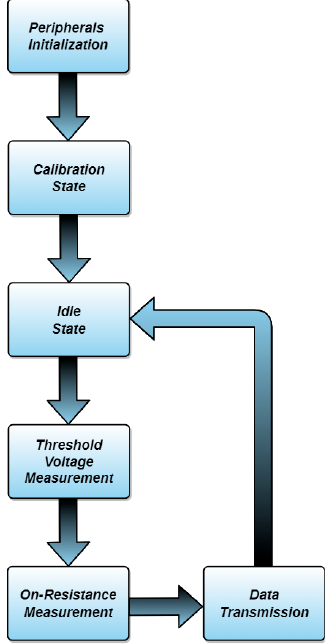
Figure 7. Firmware Finite State Machine (FSM).